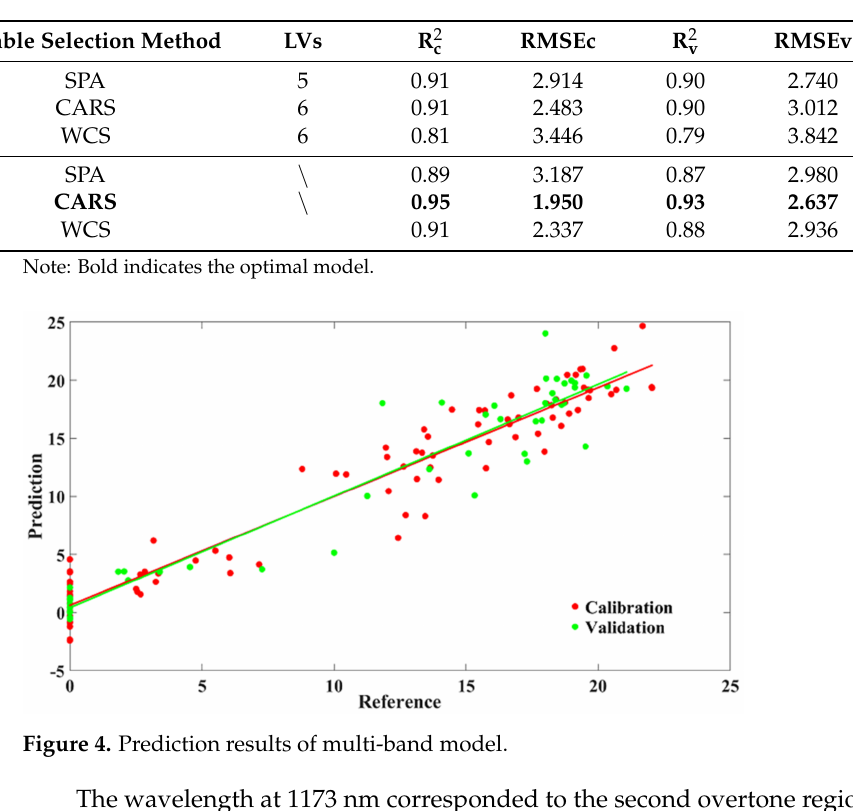
Table 4. AFB 1 prediction results of models developed by key wavelengths.